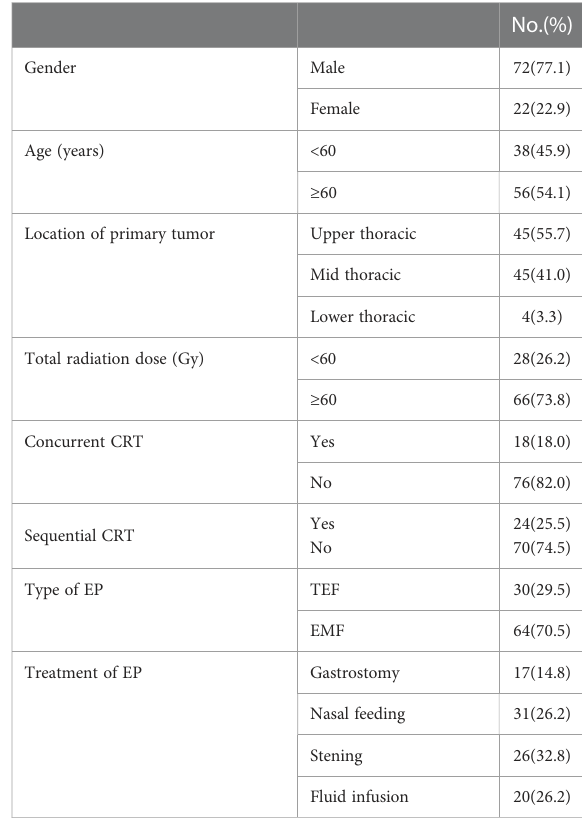
Figure 4B. A total of 17 patients had EP during radiotherapy, six patients stopped radiotherapy, and 11 patients continued